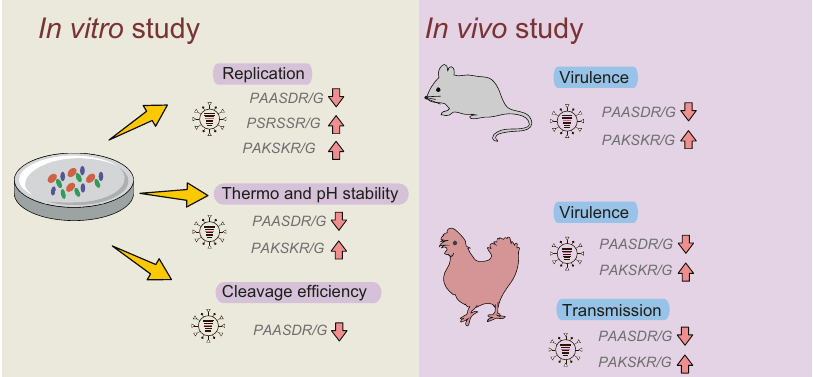
Fig. 7 Graphic summary of H9N2 viruses containing the different cleavage site motifs in vivo and in vitro. The up arrow and down arrow indicate the increase and decease,